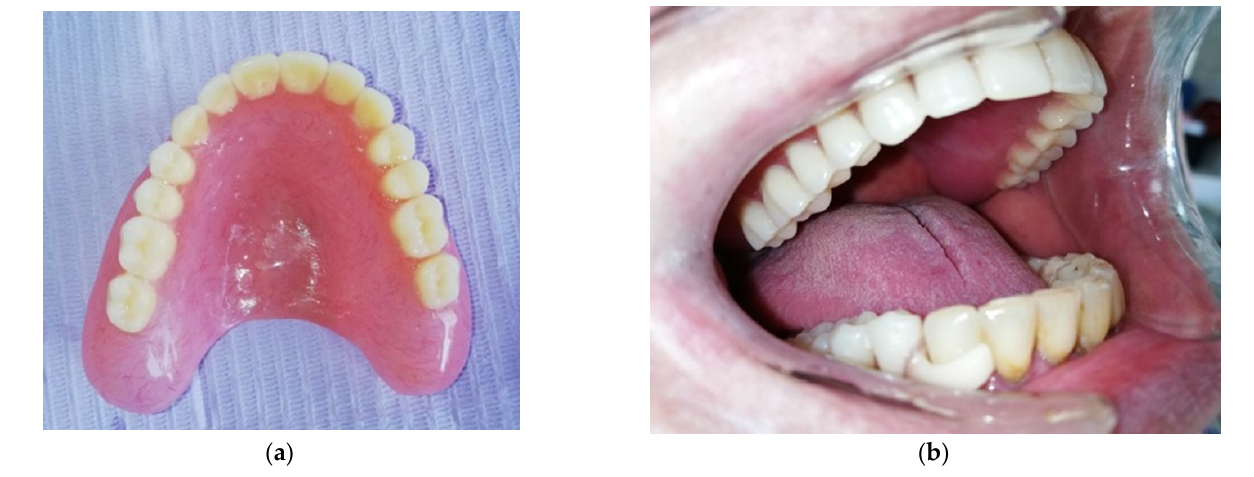
Figure 9. Final denture ( a ) extra-oral view ( b ) intra-oral view.